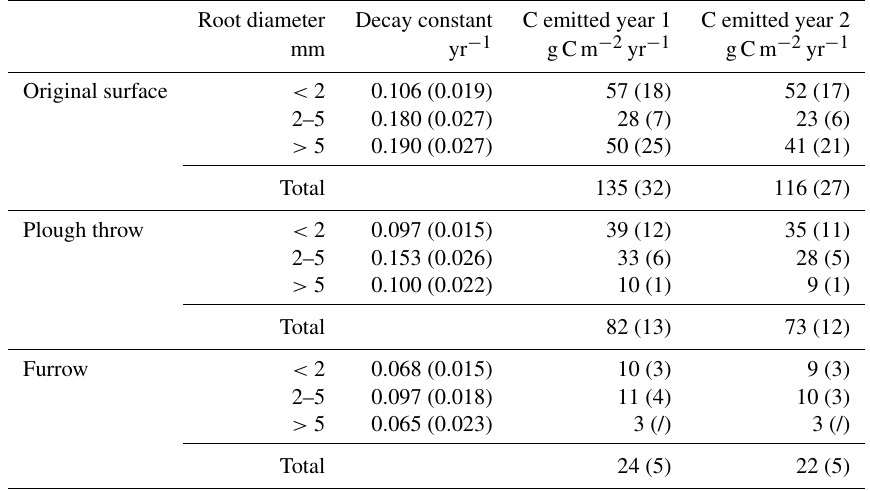
Table 4. Root decay constants and associated C emissions in trenched plots by microform and root size classes (standard error in brackets).